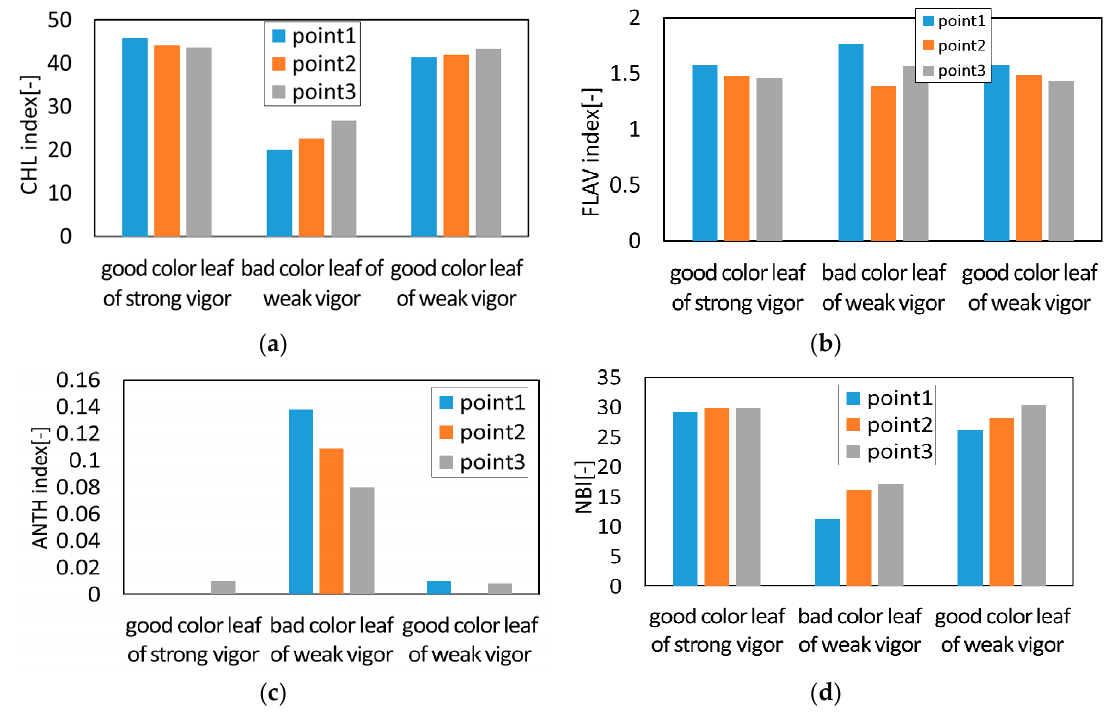
Figure 20. Comparison of each index of various leaves: ( a ) The rusult of chlorophyll; ( b ) The result of flavonol; ( c ) The result of anthocyanin; ( d ) The result of NBI.